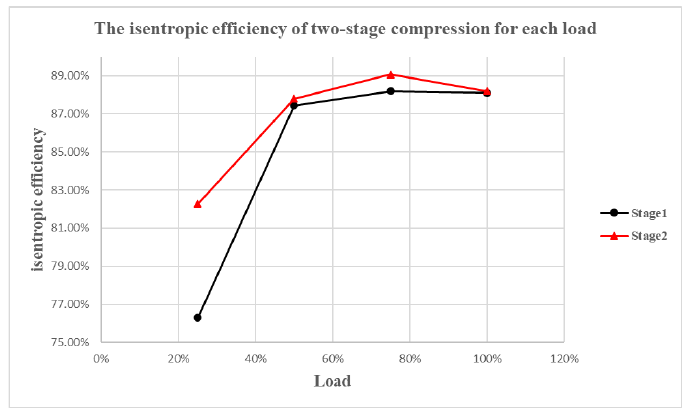
Figure 11. R-513A refrigerant two-stage compression isentropic efficiency comparison diagram under various loads.